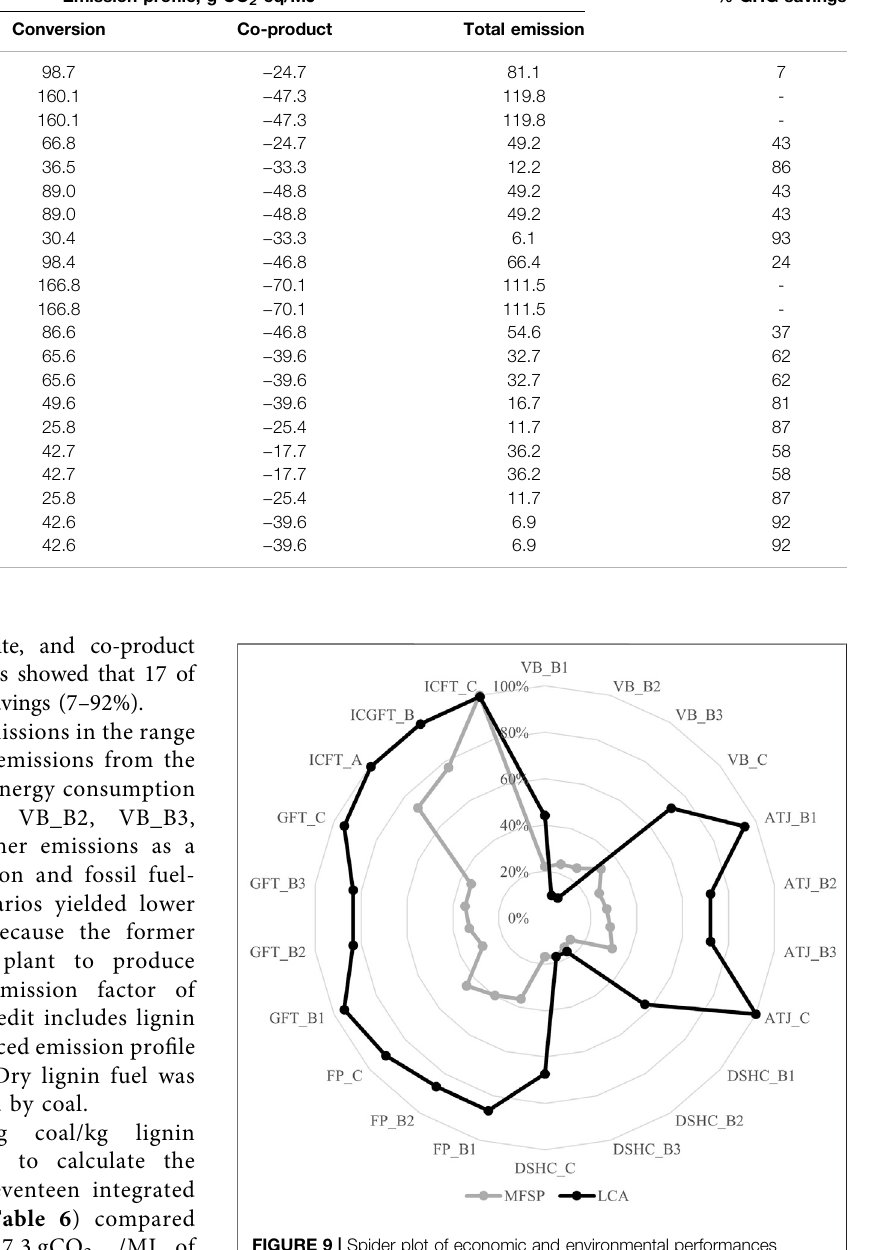
FIGURE 9 | Spider plot of economic and environmental performances for all integrated